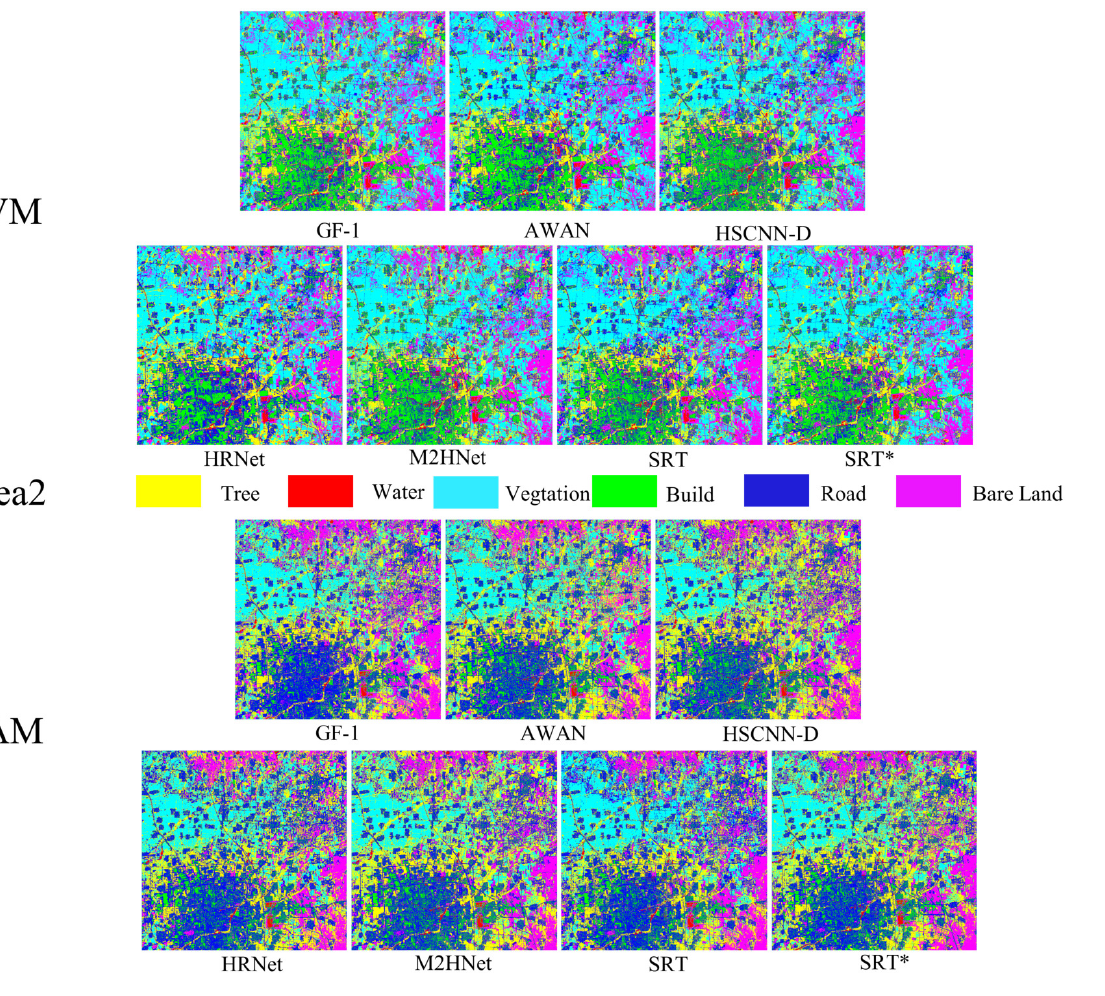
Figure 9. Result of SVM and SAM classification on